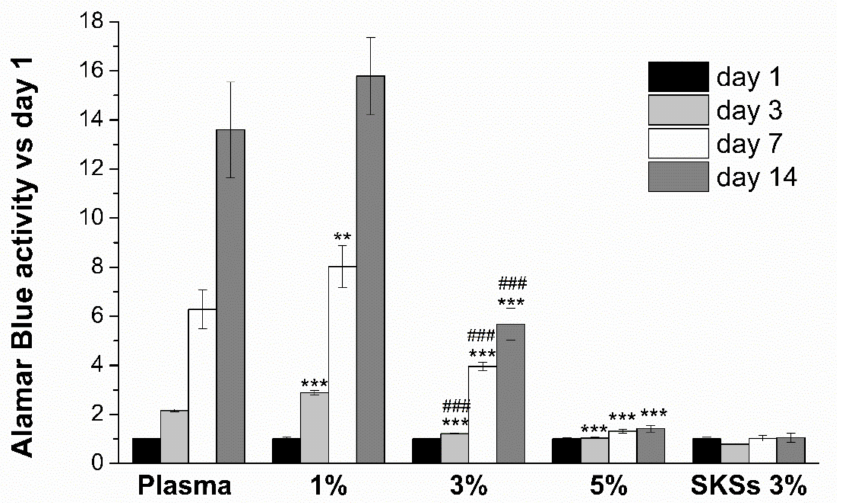
Figure 6. Alamar Blue cell proliferation for encapsulated human fibroblasts in plasma, hybrid plasma-SKSs (1%, 3% and 5%) and SKSs (3%) hydrogels over time (1, 3, 7 and 14 days) normalized respect to day 1 values. Data are reported as mean ± SD (n = 4). ANOVAs were performed for 1, 3 and 5% hybrid plasma-SKSs hydrogels respect to plasma samples at each time point (** p < 0.01 and *** p < 0.001) and for plasma-SKS 3% respect to pure elastin hydrogel (3%) at each time point at significance level of (### p <